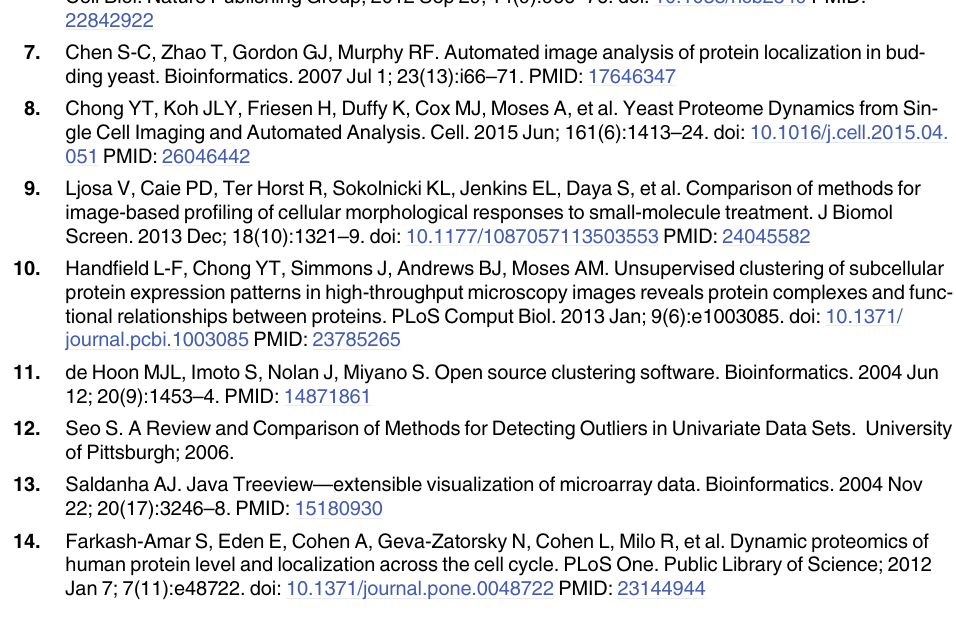
PLOS ONE | DOI:10.1371/journal.pone.0158712 July 21,